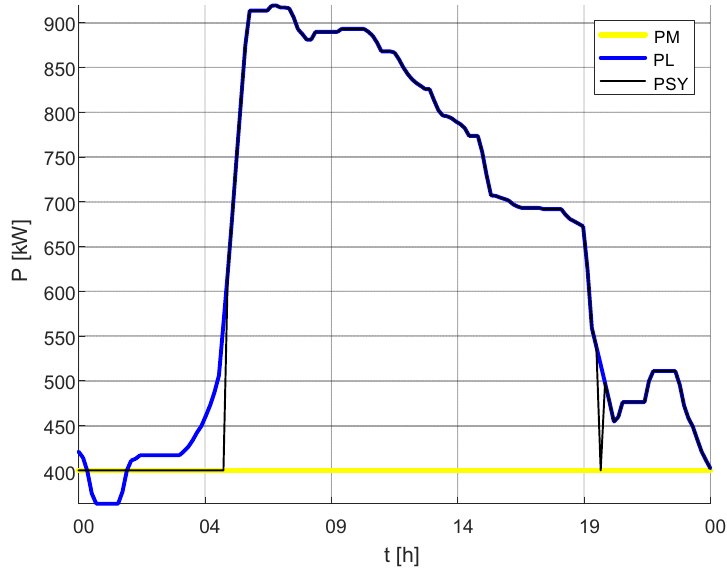
Figure 17. Results of the simulation of the operation of the private network with the BESS with real characteristics for the set PM 400 kW exchange power in the absence of generation; PSY—exchange power with the distribution grid and PL—load.